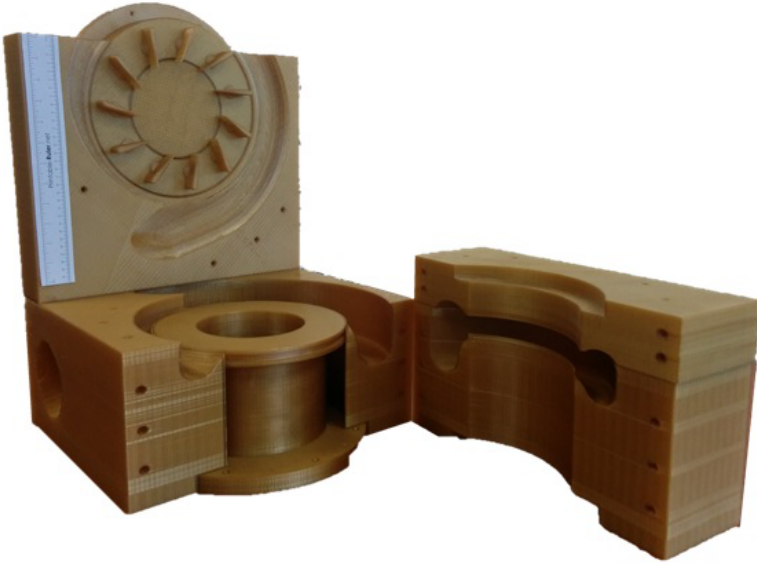
Figure 13. 3D printed scaled